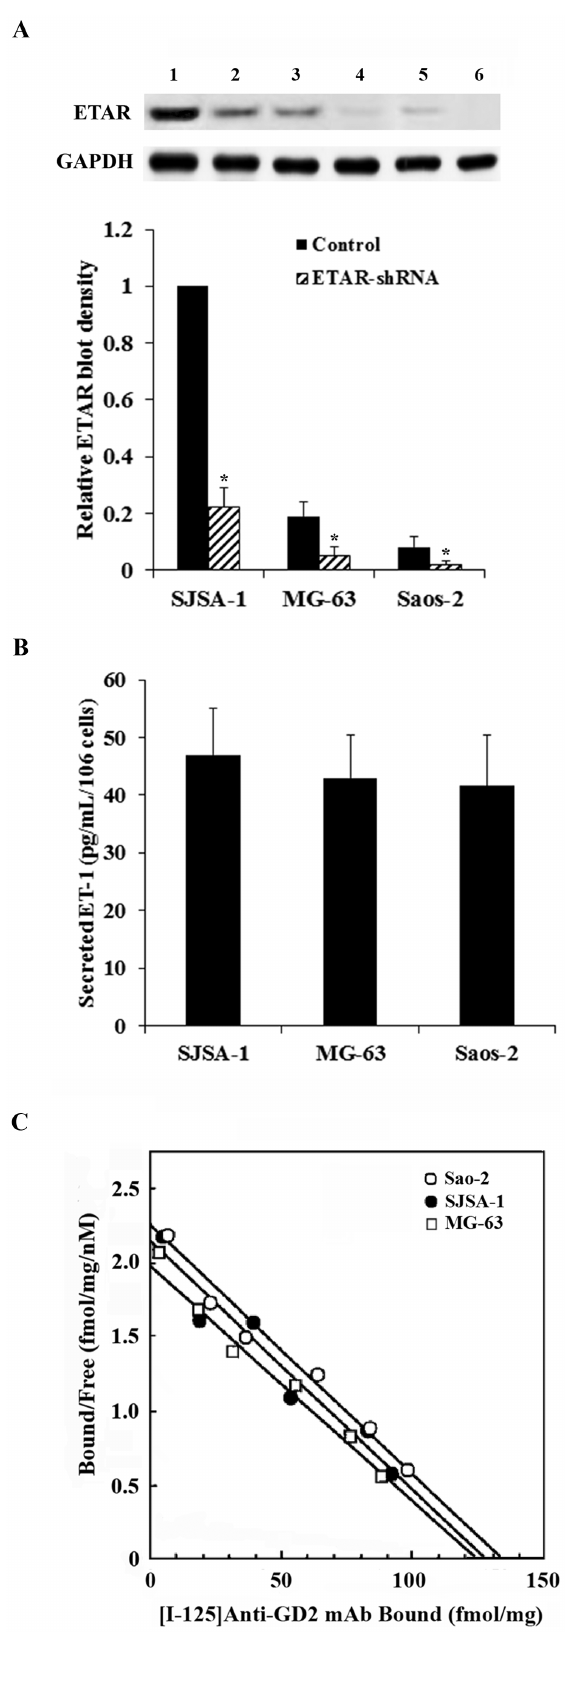
Figure 1. Endothelin-1 (ET-1) and ET A receptor (ETAR) expression levels and scatchard plot for anti-ganglioside GD2 14G2a monoclonal antibody (mAb) binding sites in human osteosarcoma (OS) cells. ( A ) ETAR levels were determined by Western blot analysis in Saos-2, MG-63 and SJSA-1 human OS cell lines. Lane 1 , SJSA-1 cells; lane 2 , SJSA-1 cells stably transduced with ETAR- shRNA; lane 3 , MG-63 cells; lane 4 , MG-63 cells stably transduced with ETAR-shRNA; lane 5 , Saos-2 cells; lane 6 , Saos-2 cells stably transduced with ETAR-shRNA. Glyceraldehyde-3-phosphate dehydrogenase (GAPDH) blotting was used as a loading control. Density of the ETAR blot was normalized against that of GAPDH to obtain a relative blot density, which was expressed as fold changes to the relative ETAR blot density of SJSA-1 control cells (designated as 1). Three independent experiments were performed for each Western blot analysis. Data values were expressed as Mean + SD. * p , 0.05 vs. control. ( B ) Secreted ET-1 levels in cell culture supernatants were quantified using ELISA and normalized against cell number (per 10 6 cells). Each ELISA experiment was repeated for three times in duplicates. Data values were expressed as Mean + SD. ( C ) Scatchard plot for binding of I-125-labeled anti- ganglioside GD2 14G2a mAb to OS